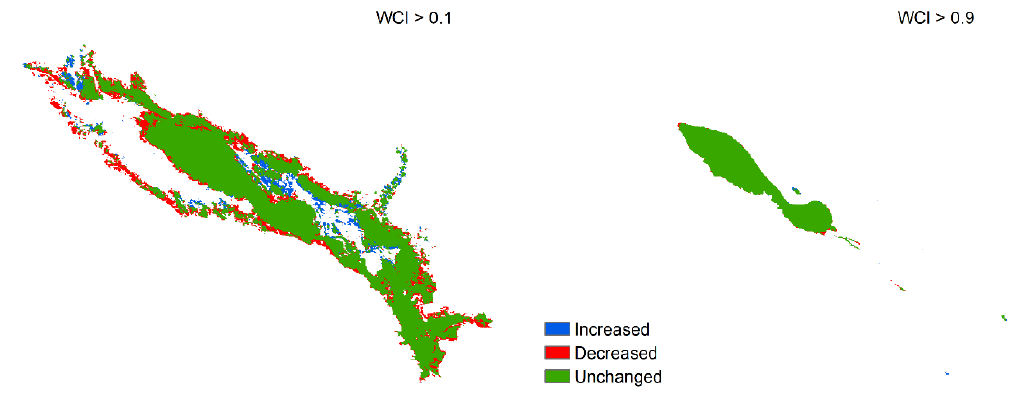
Figure 6. Variation in the Water Area of Tonle Sap before and after 2008 ( left : flooding area with WCI > 0.9, right : lake area with WCI > 0.1). Table 4. Comparison of the Average Lake Area before and after 2008.